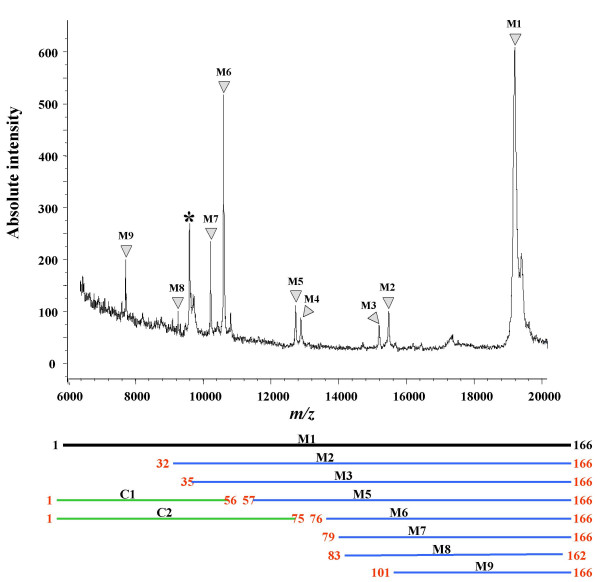
MALDI-TOF mass spectrum of large peptide fragments produced by SSO0551 partial trypsin proteolysis. A partial enzymatic proteolysis was carried out during 60 sec at 20°C with a trypsin/SSO0551 protein ratio of 1/20 (w/w). The products were then resolved onto a C8 reverse phase chromatographic column and the different UV absorbing fractions were analyzed by MALDI-TOF. The m/z spectrum obtained with the fraction eluting at 40–50 % acetonitrile is shown. The asterisk labels a peak arising from trypsin autolysis. Peaks that could be assigned are identified with numbers (experimental m/z, residues, Δmass in ppm compared to theoretical [M+H]+ average mass): M1 (19198.4, [1–166], -1), M2 (15478.7, [32–166], -53), M3 (15191.2, [35–166], +153), M4 (12883.4, [52–162] or [56–166], -46 or -43), M5 (12724.2, [57–166], +193), M6 (10603.8, [76–166], +51), M7 (10220.1, [79–166], +77), M8 (9257.2, [83–162], +63) and M9 (7717.0, [101–166], -134). Peptides C1 and C2, complementary of M5 and M6, were not observed in this spectrum but in another fraction from the C8 reverse-phase chromatography corresponding to smaller peptides.